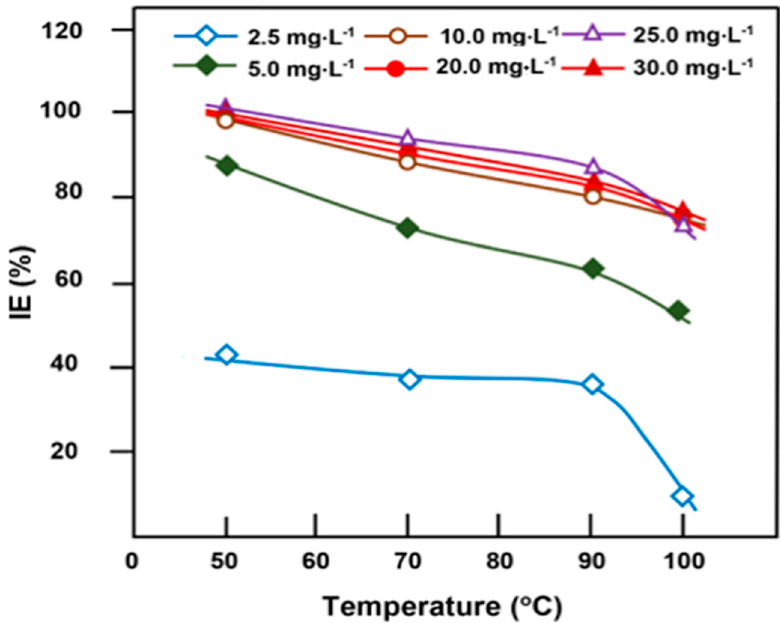
Figure 5. Variation in the scale IE versus the temperature in the media at a pH of 7.5 and 1000 mg · L − 1 Ca 2+ .